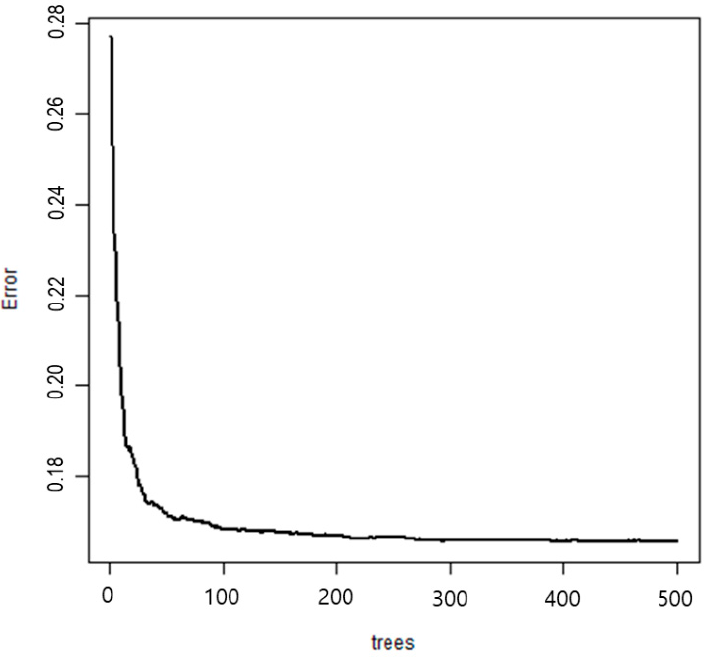
Figure 6. Error graphs of random forest.